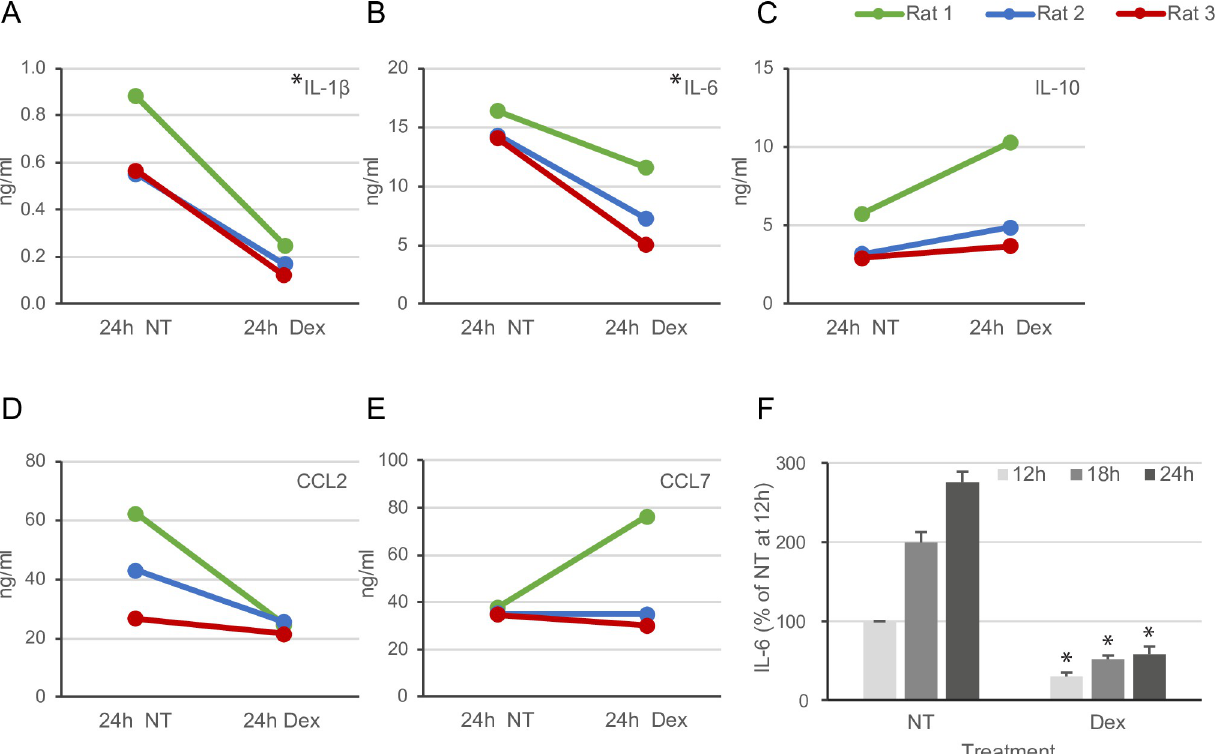
Fig 7. Cytokine production in rat LSECs treated with Dex. (A-E) Expression of selected cytokines and chemokines in supernatants of rat LSEC cultures ± 1 μ g/ml Dex, measured by Luminex multiplex immunobead assay (n = 3). � Significantly different from 24 h non-treated (NT, Paired Samples T-test, p < 0.05). (F) IL-6 production (single ELISA) at 12, 18, and 24 h in rat LSEC cultures ± 1 μ g/ml Dex (n = 3). � Significant difference between Dex and time-matched NT groups (one-way ANOVA, p < 0.05).